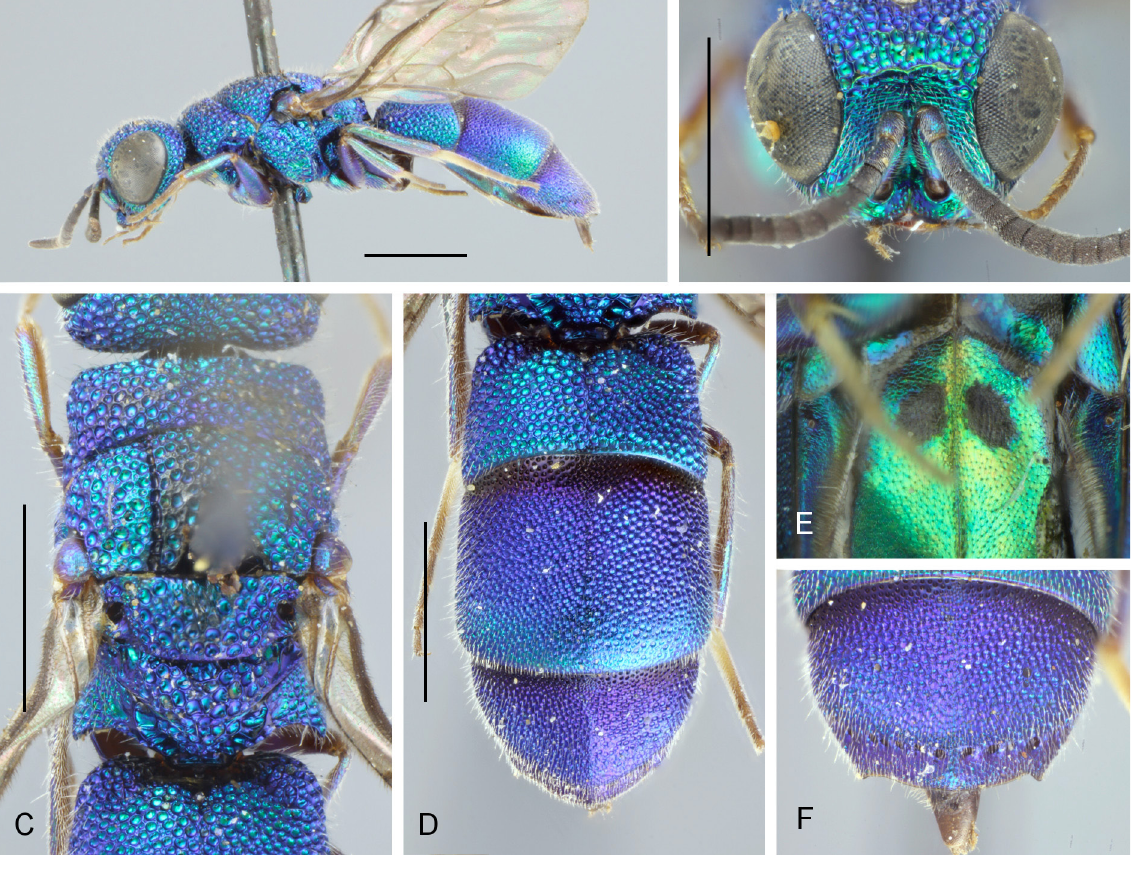
Fig. 3. Chrysidea vazimba sp. nov., holotype, ♀. A . Lateral habitus. B . Head. C . Mesosoma. D . Metasoma. E . Black spots on S2. F . T3. Scale bars = 1.0